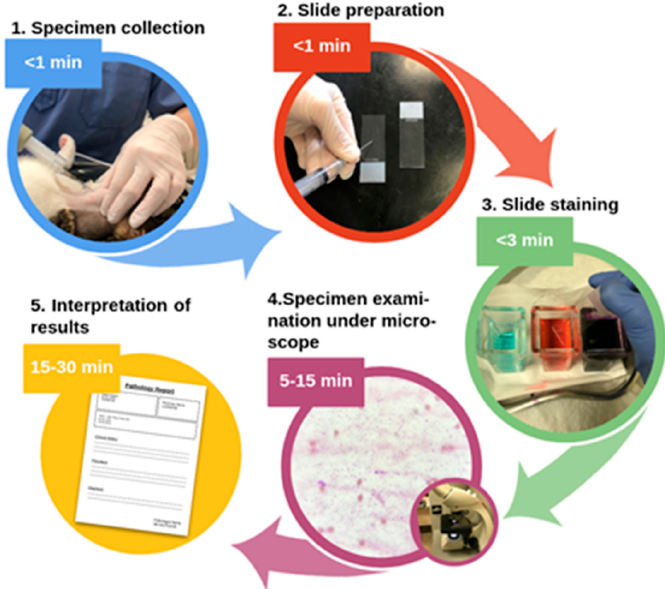
Figure 1. Fine-needle cytology method. ( 1 ) Specimen collection: cells are collected from the neoplasia; ( 2 ) slide preparation: aspirated material expelled on the slide, smeared using the second slide, and dried; ( 3 ) slide staining: slide stained using the Diff-Quik staining method [12]; ( 4 ) specimen examination under a microscope: veterinary pathologist conducts a visual examination of the stained material; ( 5 ) interpretation of results: inflammatory process from neoplasia differentiated (when possible), neoplasia classified into 1 of 3 categories (epithelial, mesenchymal, or round cell neoplasia) and the prognostic answer is given (benign tissue or malignant tumor).